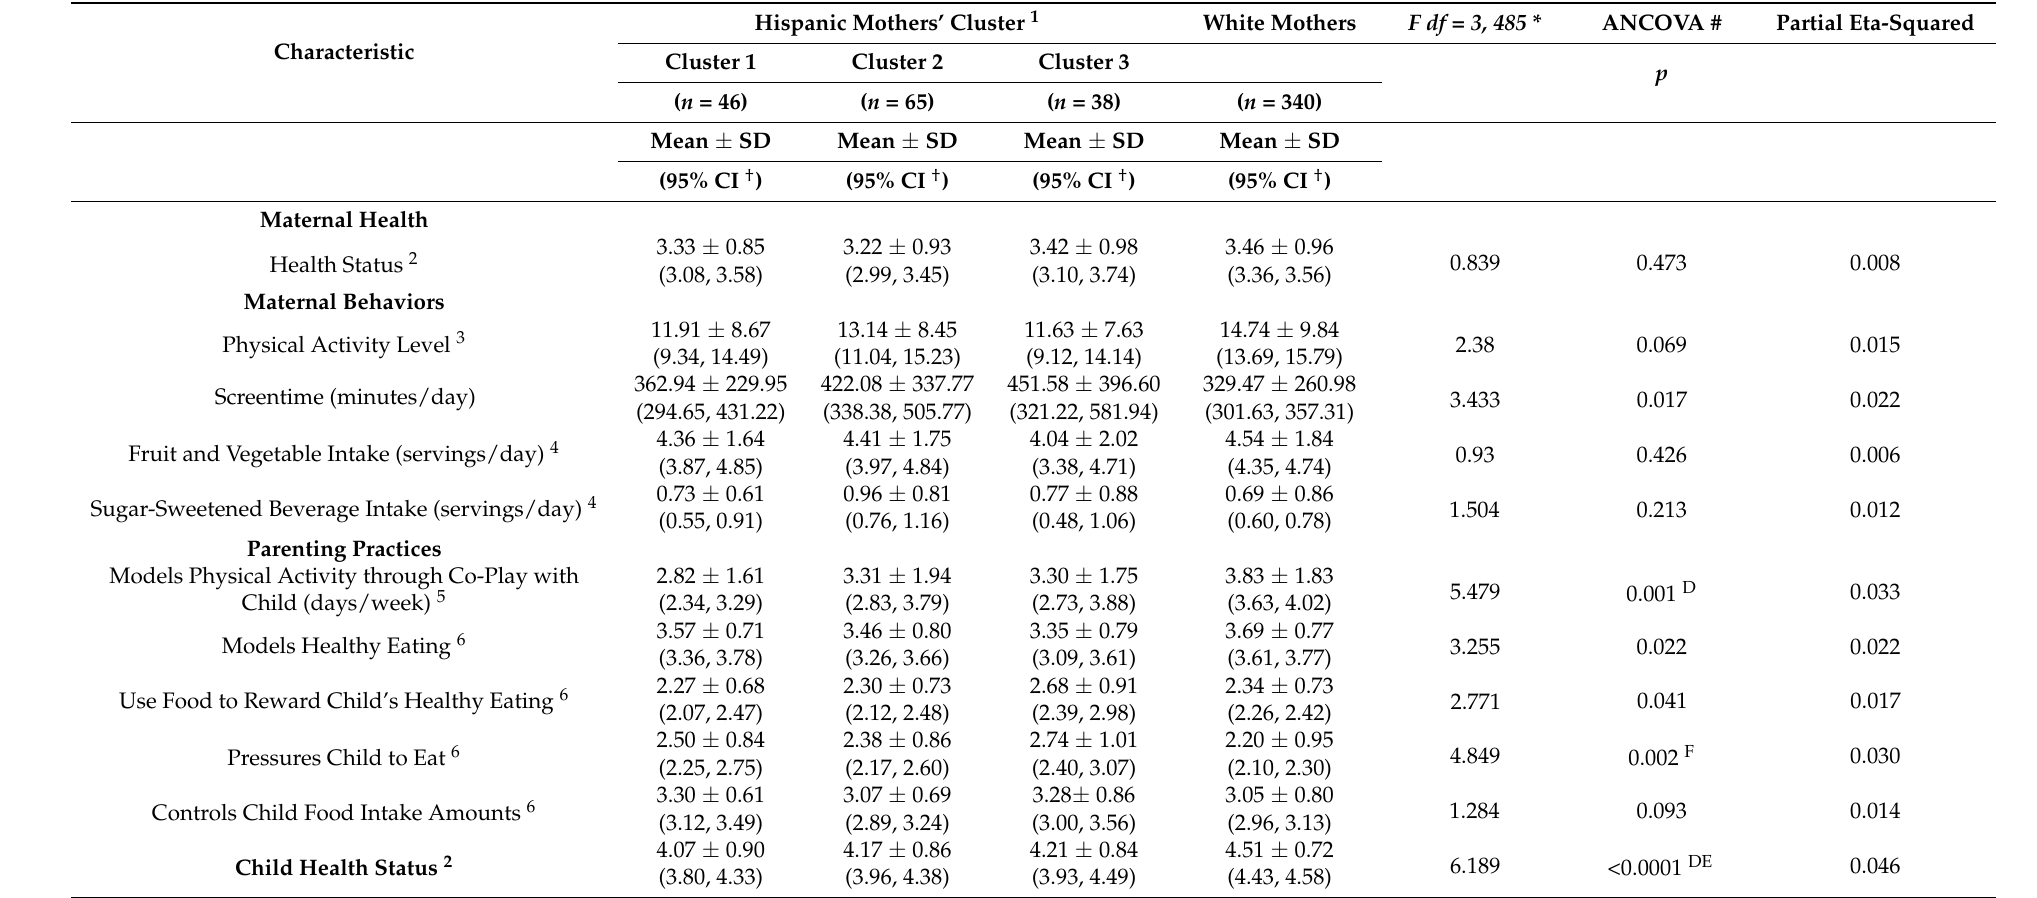
Table 4. Mother and Child Health and Weight-Related Behaviors ( n =